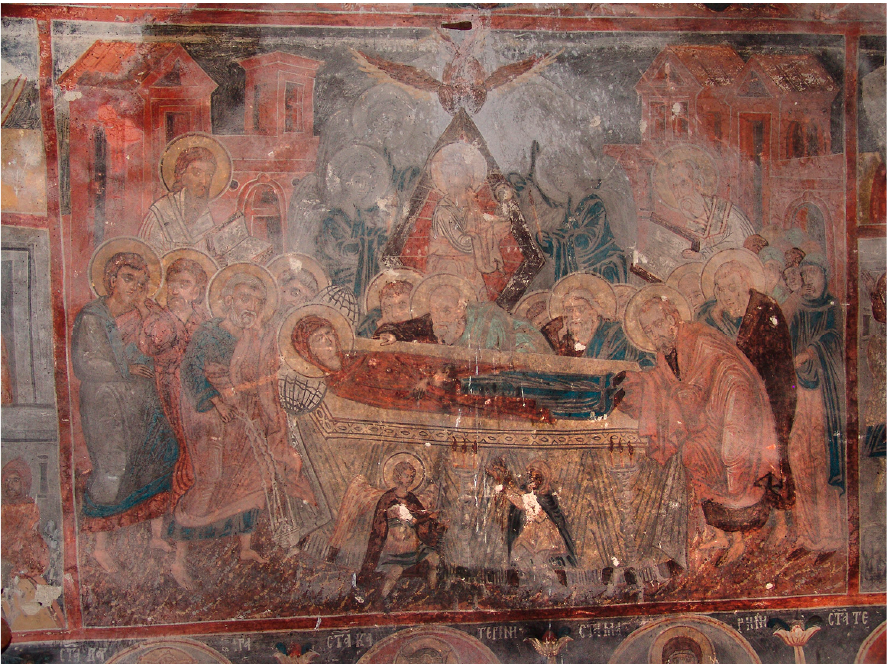
Figure 12. Dormition of the Theotokos , wall painting, 1626, Ascension Church, Alino Monastery, Bulgaria. (Photo credit: Ivan Vanev, The Roads of the Balkan Painters and Post-Byzantine Artistic Heritage in Bulgaria Project, http://zografi.info/, accessed on 2 February 2023).